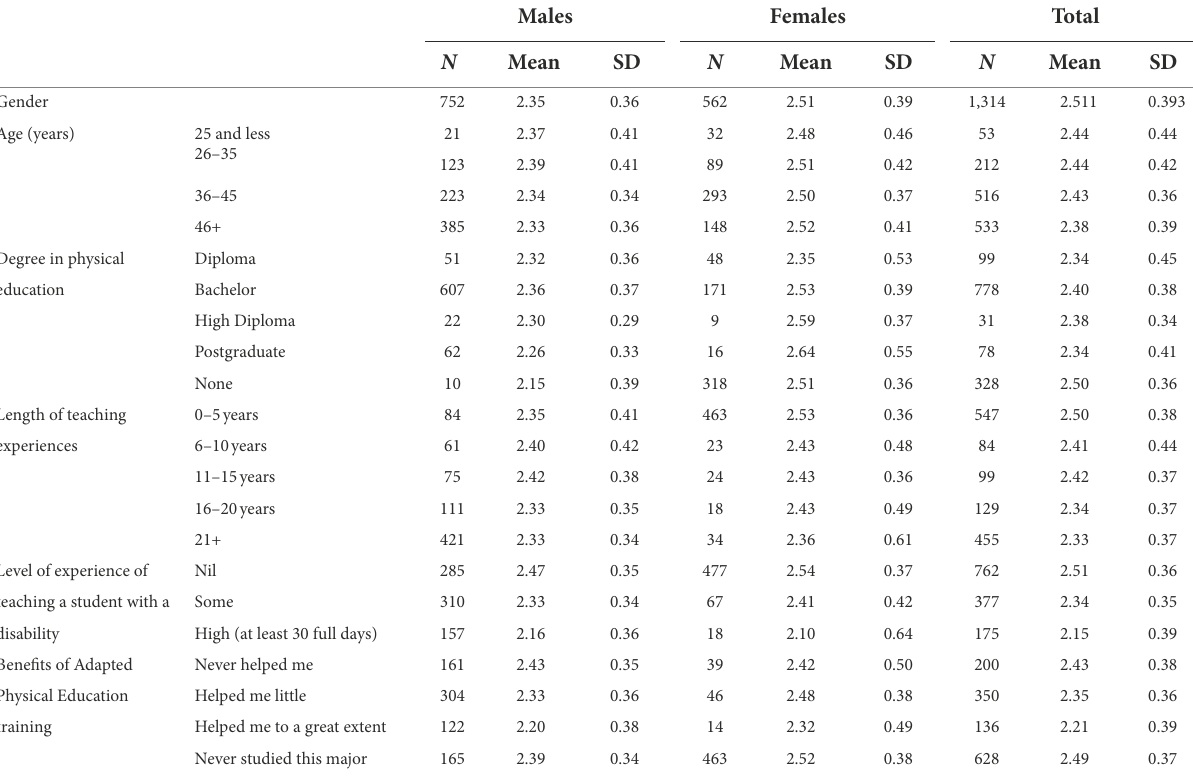
TABLE 1 Mean and standard deviation of attitudes toward inclusion among PE teachers stratified by gender, age, and sociodemographic